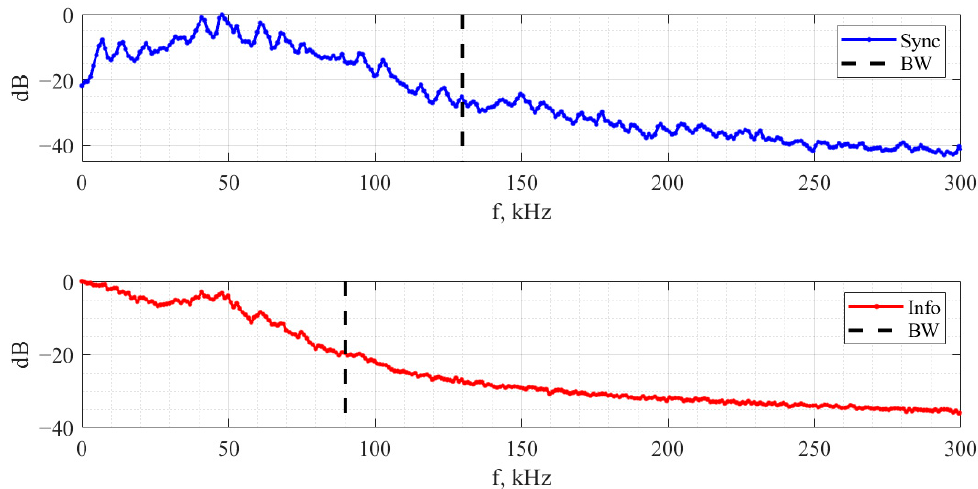
Figure 10. RC two-transistor oscillator synchronization (blue) and information-carrying (red) signal spectra.